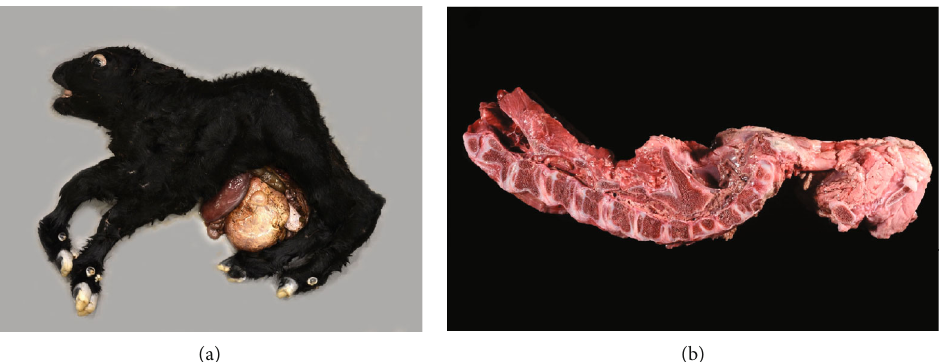
Figure 1: Gross necropsy photos of the stillborn male Angus calf with appreciable congenital deformities: short and rounded skull, maxillary brachygnathism, arthrogryposis, vertebral aplasia, and abdominal organ herniation (a). A longitudinal section of the spine in right lateral orientation (b) highlights agenesis of the lumbosacral and caudal vertebra and spinal cord agenesis abnormalities as are characteristic of perosomus